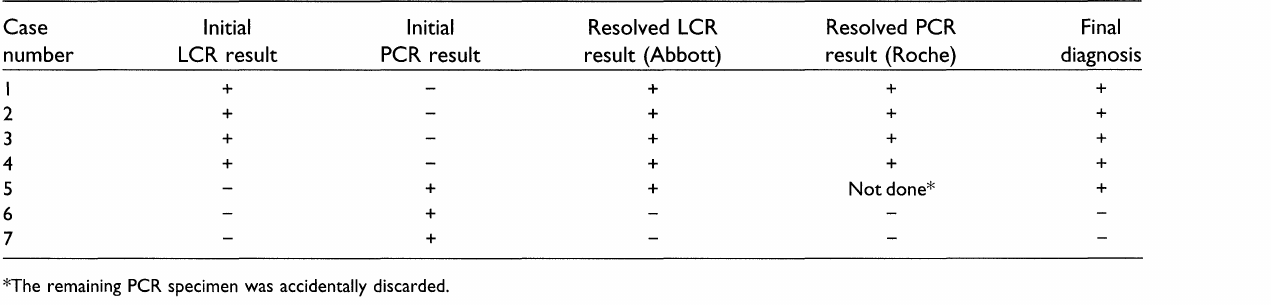
TABLE I. Resolution of discrepant results at Abbott and Roche Laboratories